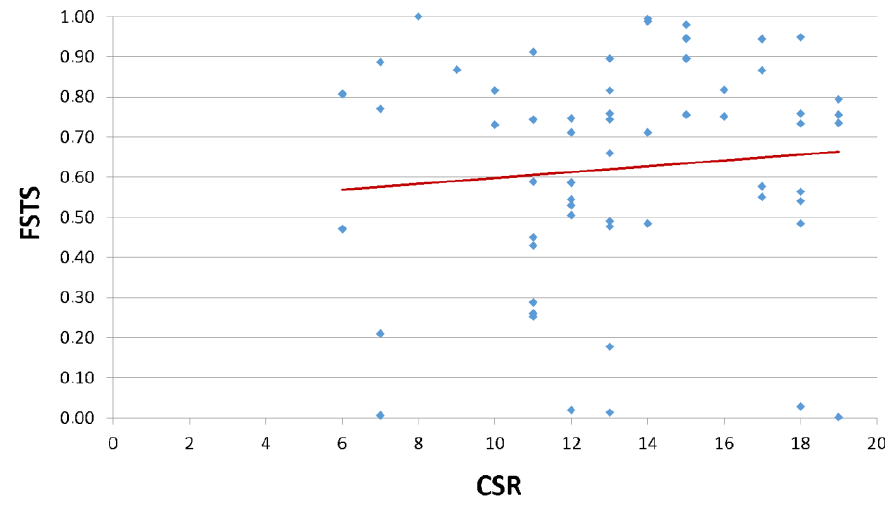
Figure 1. Relationship between CSR and FSTS (Foreign Sales over Total Sales).